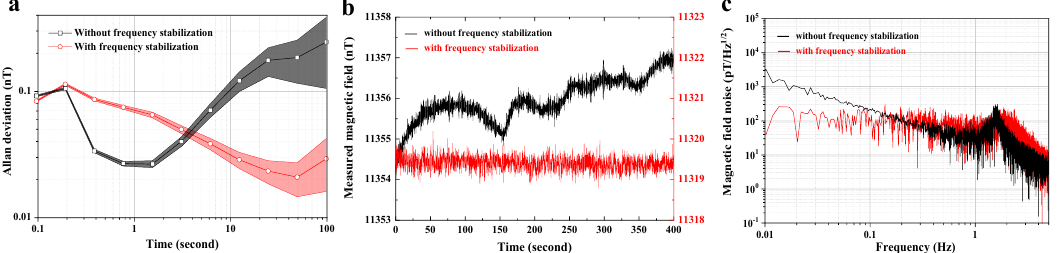
Figure 4. ( a ) The Allan deviation of the measured results of the magnetometer with and without frequency stabilization. ( b ) The measured results in the time domain. ( c ) The measured results in the frequency domain. The bandwidth of the laser pumped 4 He magnetometer is about 5 Hz and is determined by the time constant of the lock-in amplifier and the parameter settings of the PID